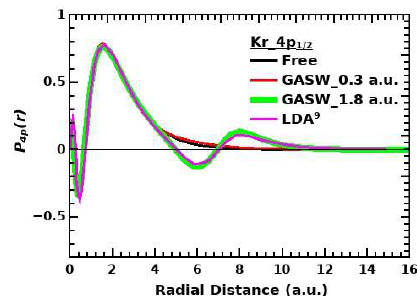
Figure 6. The large component of 4p1/2 radial wavefunction of free and confined